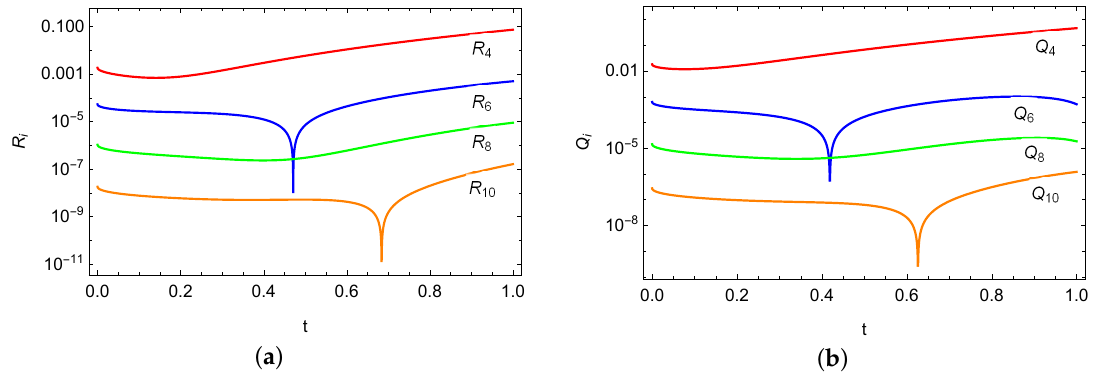
Figure 9. The presentation of convergence for the input data disturbed by the 10% error: ( a ) temperature distribution, where R i = | (cid:98) θ i ( t ) − (cid:98) θ i − 1 ( t ) | , ( b ) heat flux, where Q i = | (cid:98) q i ( t ) − (cid:98) q i − 1 ( t ) | .